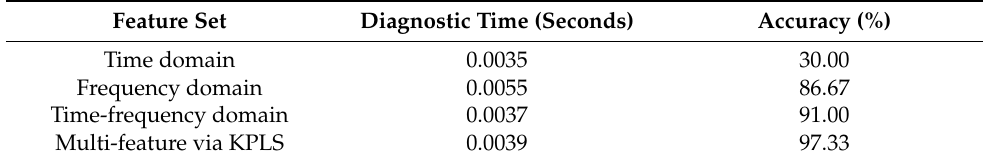
Table 6. Diagnosis results under different feature sets.